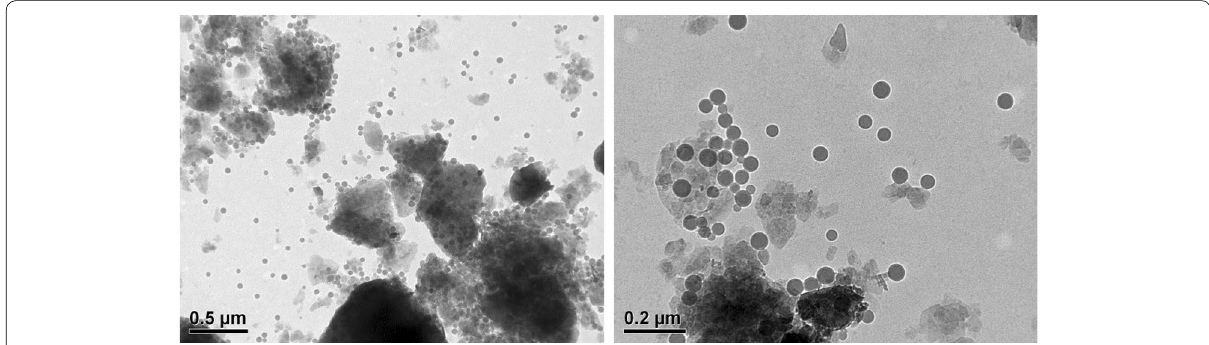
Fig. 1 Transmission electron microscope (TEM) image of PS‑NP in